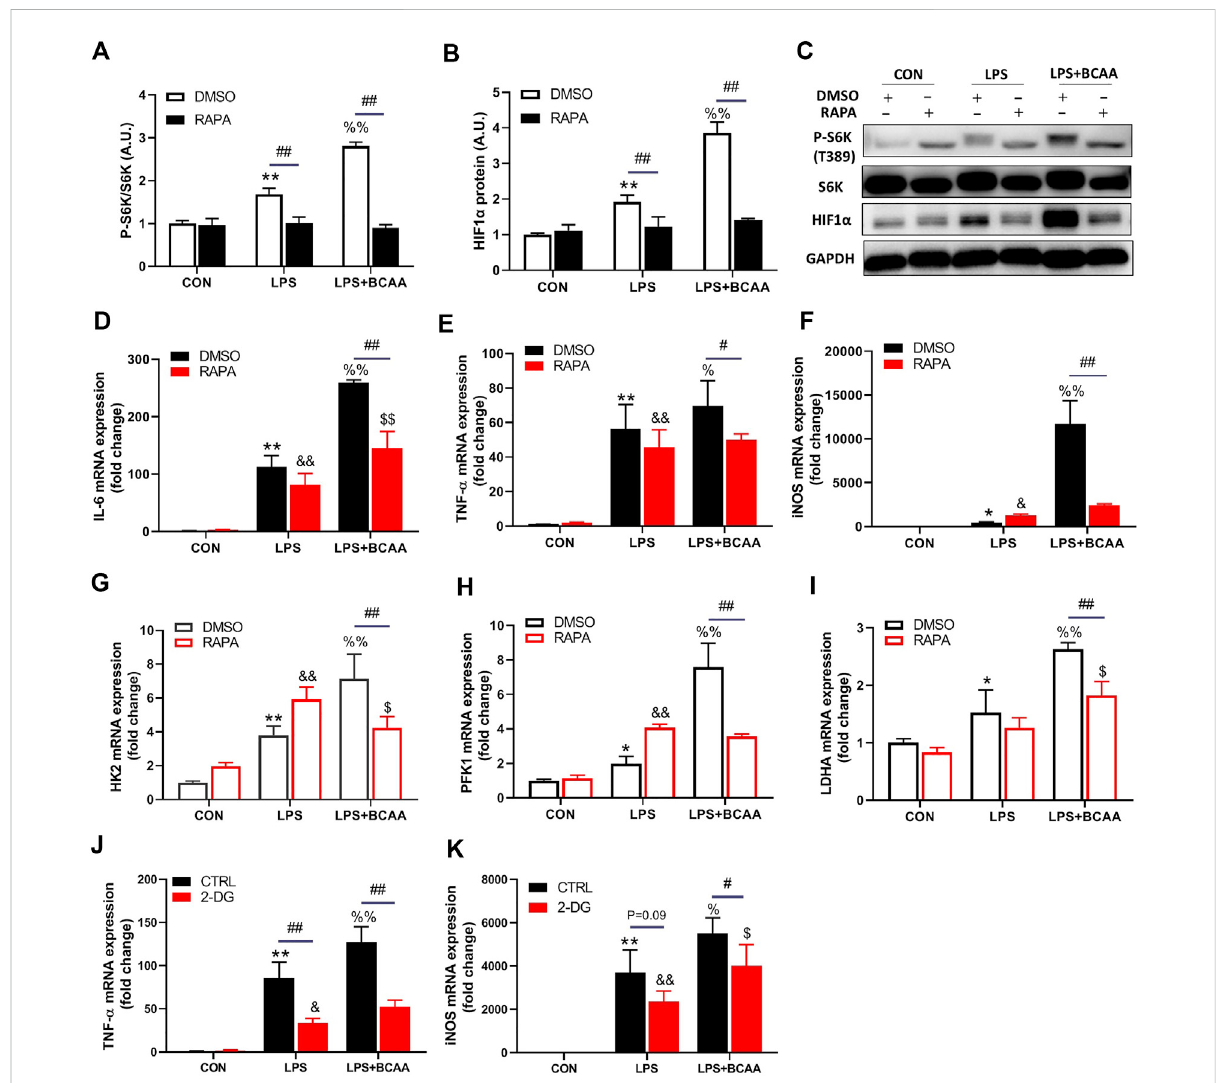
FIGURE 5 BCAAs promote M1 polarization via mTORC1-HIF1 α -glycolysis pathway. (A – C) BCAAs (800 μ m) promoted the expression of HIF1 α and mTORC1 activation during M1 polarization, and the effect of RAPA (rapamycin, mTORC1 inhibitor) on the expression of HIF1 α . (D – F) Changes of M1 polarization with RAPA. (G – I) The effect of RAPA on the rate-limiting enzyme of glycolysis. (J,K) Changes of M1 polarization with 2-DG, a glycolysis inhibitor.Dataarepresentedasmean±SEM.* p < 0.05,** p < 0.01vs.CON/DMSOCON/CTRLCON; & p < 0.05, && p < 0.01vs.RAPA/2- DGCon; % p < 0.05, %% p < 0.01vs.LPS/DMSOLPS/CTRLLPS; $ p < 0.05, $$ p < 0.01vs.RAPA/2-DGLPS; # p < 0.05, ## p < 0.01betweengroupsLPSorLPS +